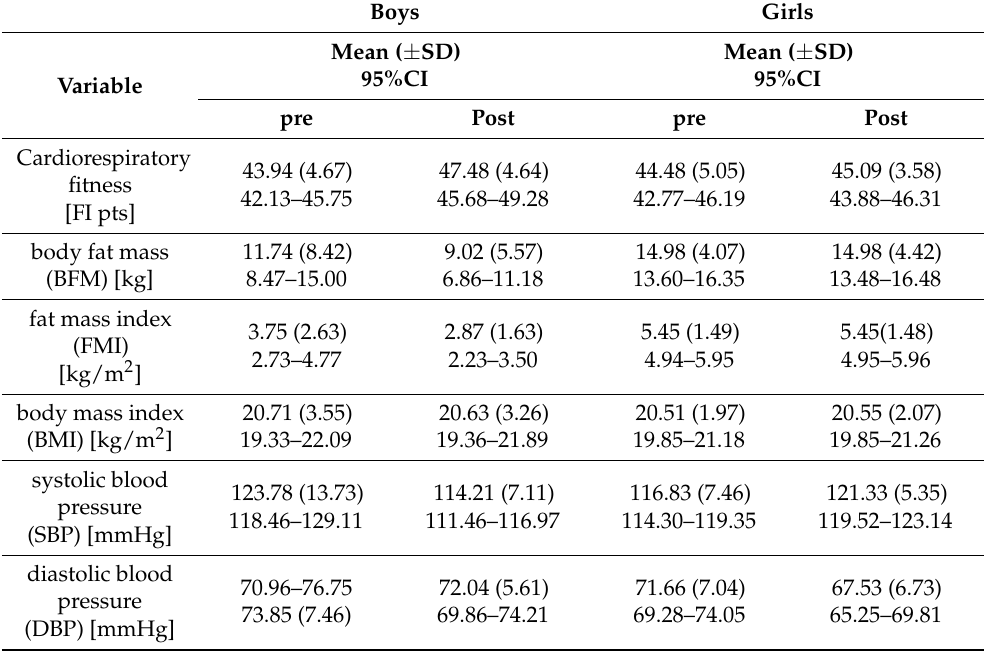
Table 1. Descriptive statistics of the baseline and postintervention cardiorespiratory fitness (CRF), body fat mass (BFM), fat mass index (FMI), body mass index (BMI), and blood pressure (systole—SBP and